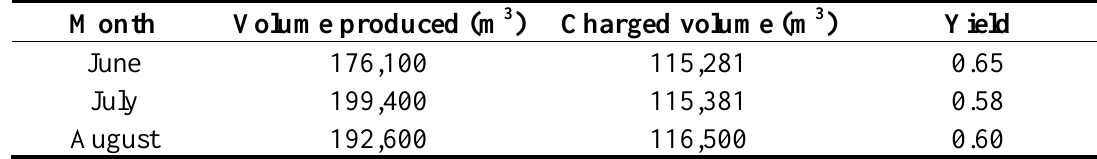
Table1. Volume of water distributed in